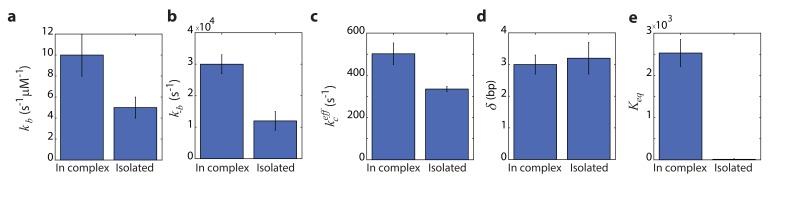
The global fitting parameters reveal a shift towards the post translocation state of RecD when in complex.(a) Forward ATP binding rate, kb. (b) Backward binding rate, k-b. (c) effective catalytic rate, kceff. (d) Step size, δ. (f) Equilibrium constant of translocation, shifted by the complex toward the post-translocation state.